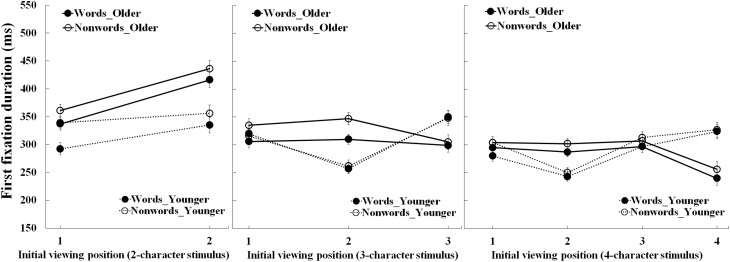
First fixation duration for the older and young adults as a function of the initial viewing position and stimulus type. Bars correspond to standard errors.